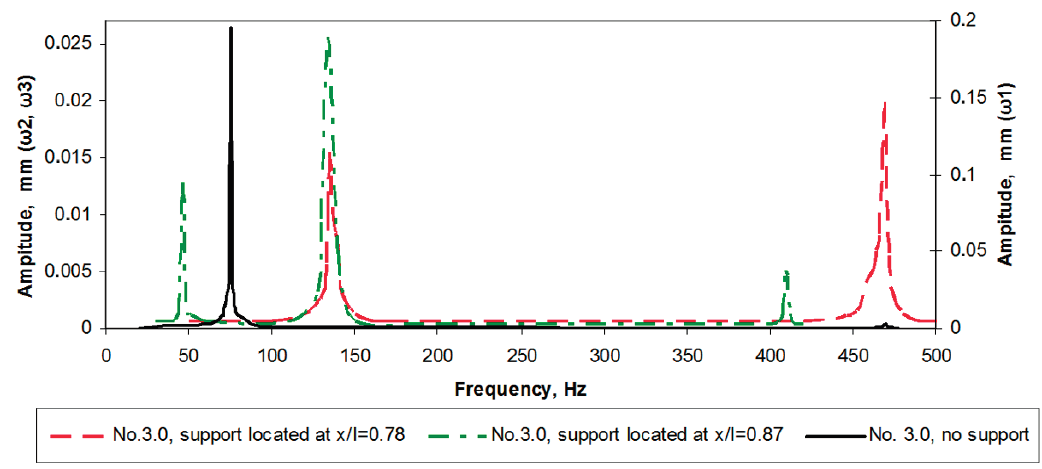
Figure 16. Amplitude-frequency characteristics for the constant cross-section cantilever.